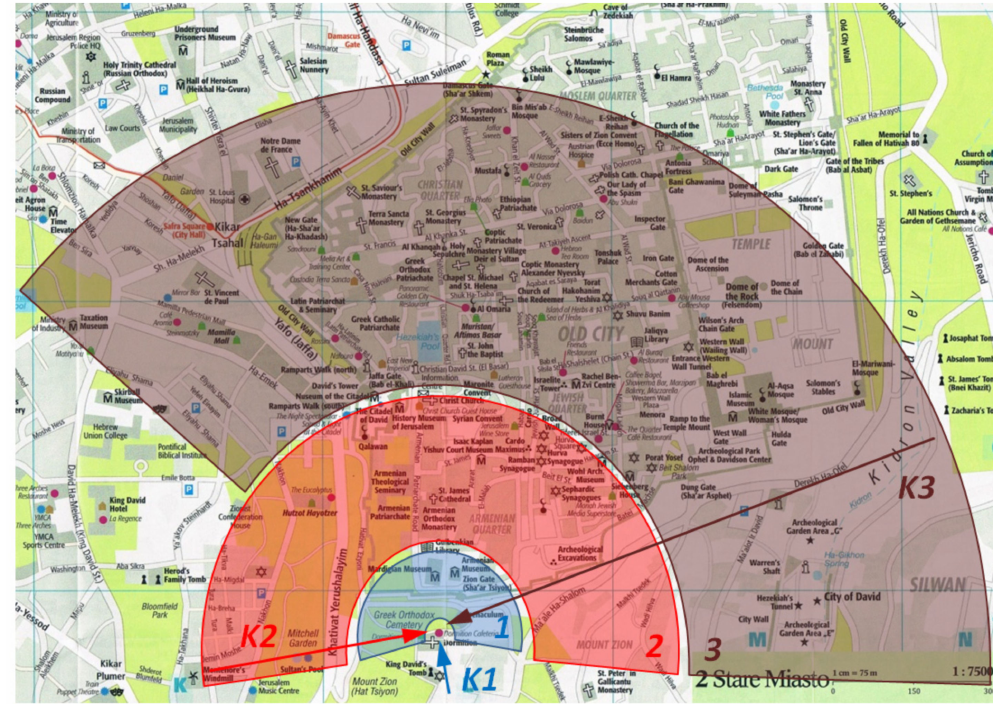
Figure 5. Object visibility zones and directions